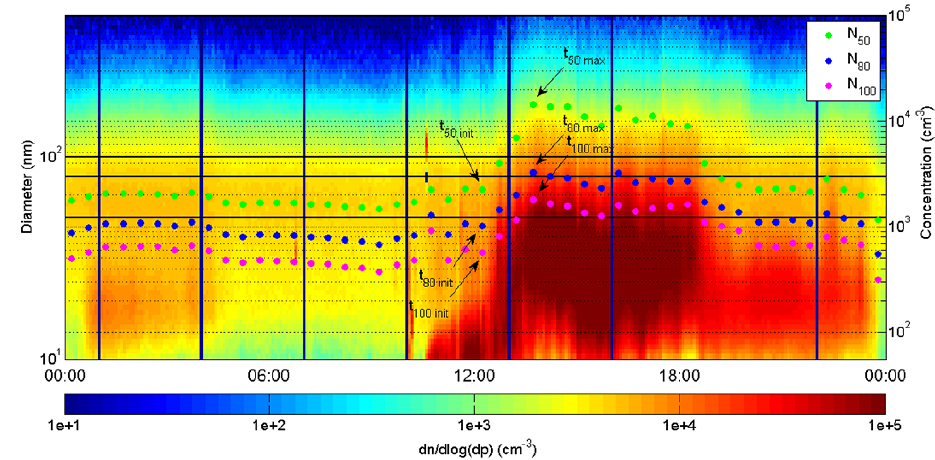
Figure 1. Determination of the CCN concentration increase for the three threshold diameters (50, 80 and 100nm) from the particle-size distributions measured by SMPS. t init and t max denote, for each diameter, the times from which concentration increases are calculated. 24 July